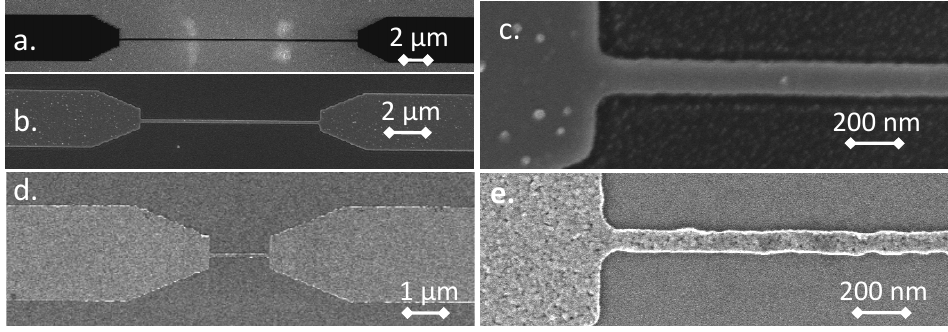
Figure 4. Validation of NIL stamp. ( a ) EBL-fabricated nanostencil. ( b ) and ( c ) are stamp details corresponding to nanowire designs. ( d ) and ( e ) resulting metal patterns after